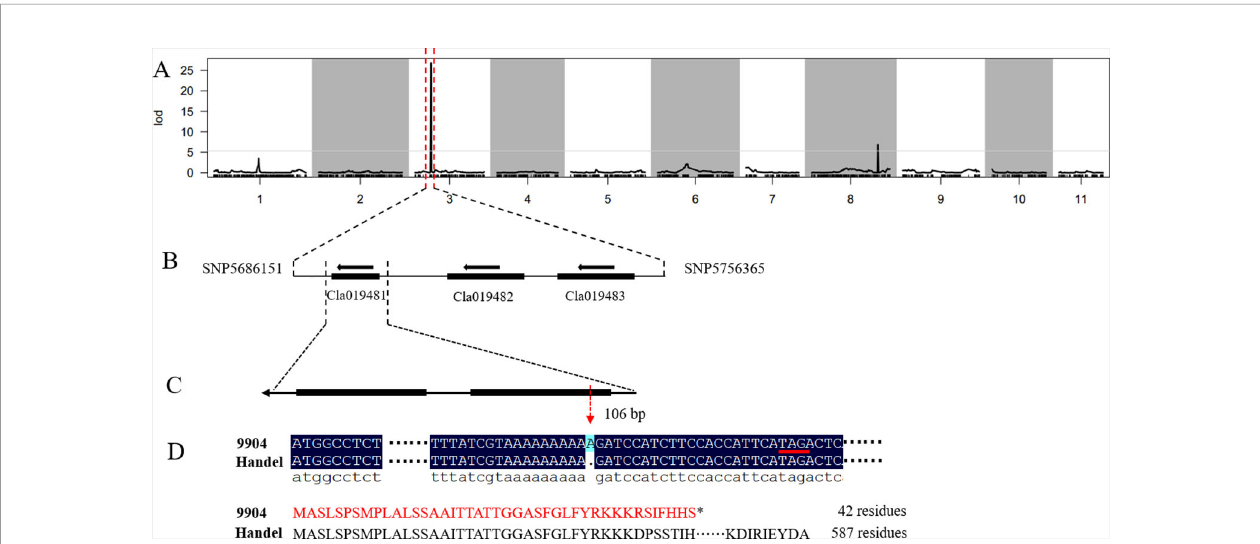
FIGURE 1 | Genetic mapping of the seed coat color gene and candidate gene analysis in watermelon. (A) The candidate gene was located on chromosome 3. (B) The candidate gene was localized to a 70.2 kb region between the fl anking markers SNP5686151 and SNP5756365. (C) Structure of the Cla019481 gene. (D) A frameshift mutation and early termination of translation in